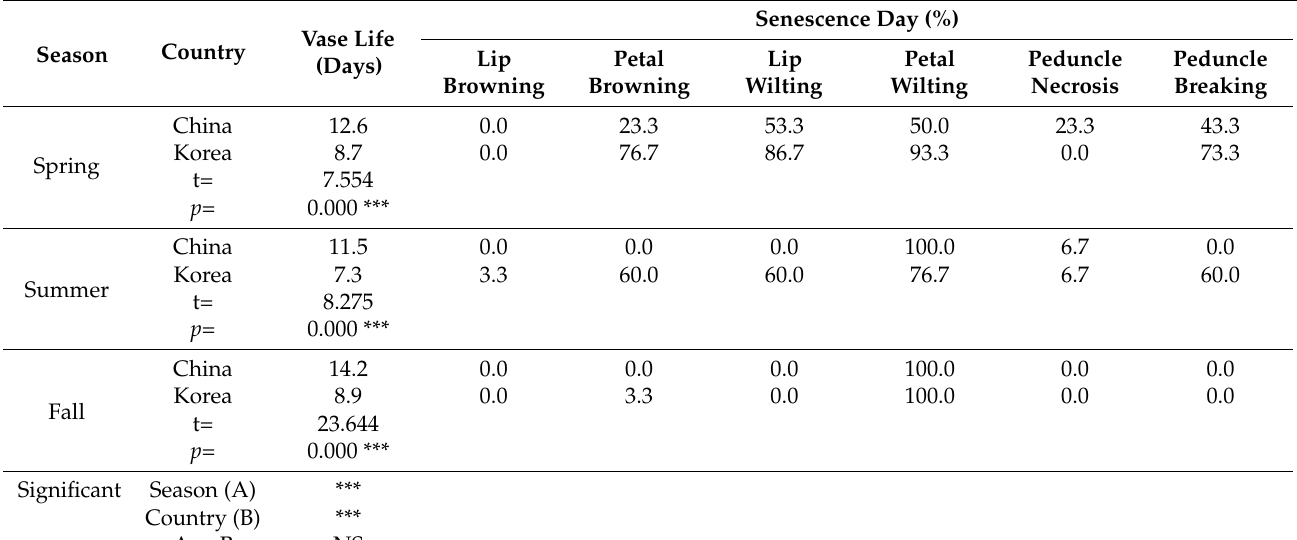
Table 1. Vase life and senescence type of cut Phalaenopsis “V3” flowers based on the place of origin and season.